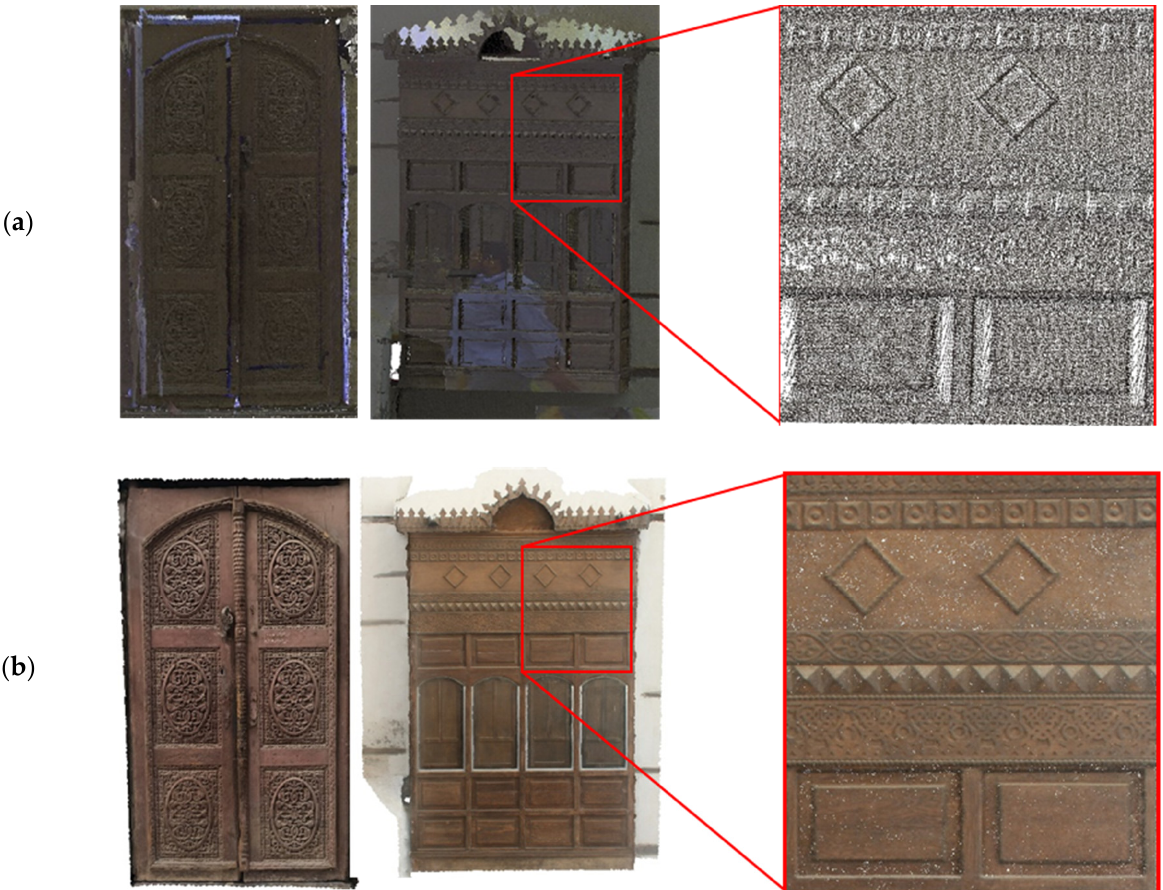
Figure 10. Three-dimensional Hijazi architectural element modeling using ( a ) TLS and ( b ) photo- grammetry.